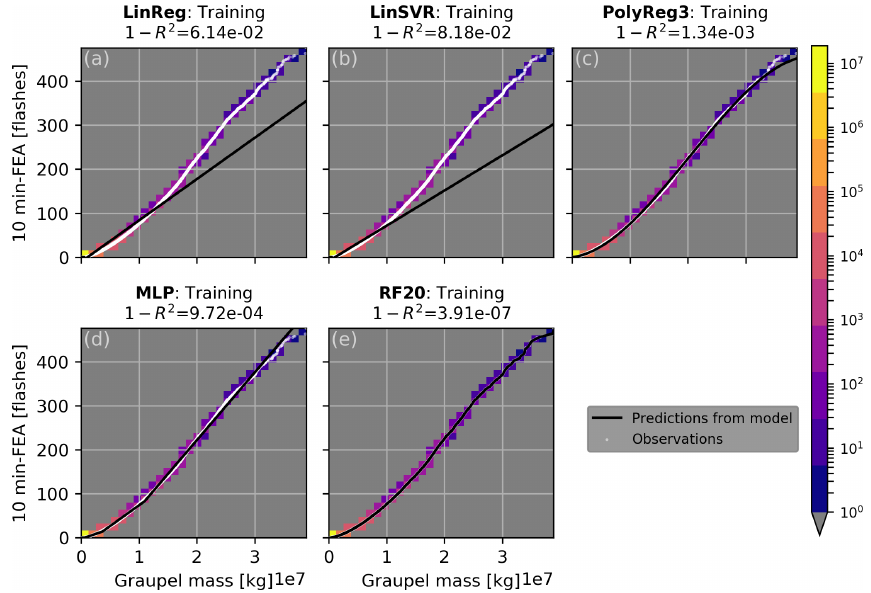
Figure 6. Model training curves in black for (a) linear regression, (b) linear support vector machine, (c) cubic polynomial regression, (d) multi-layer perceptron and (e) random forest regression overlaid on the global sorted distribution of observed FEA versus simulated graupel mass in white. The colour shades represent the number of points in each bin of 0 . 13 × 10 7 kg width.